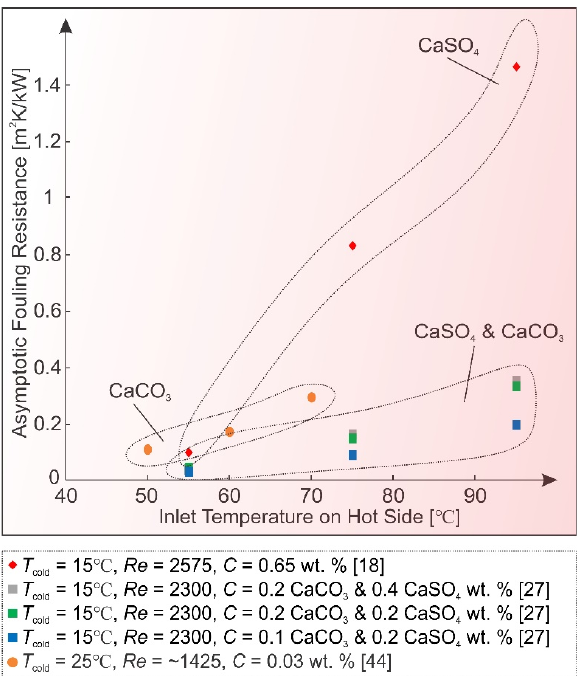
Figure 5. Inlet hot temperature effect on asymptotic fouling resistance